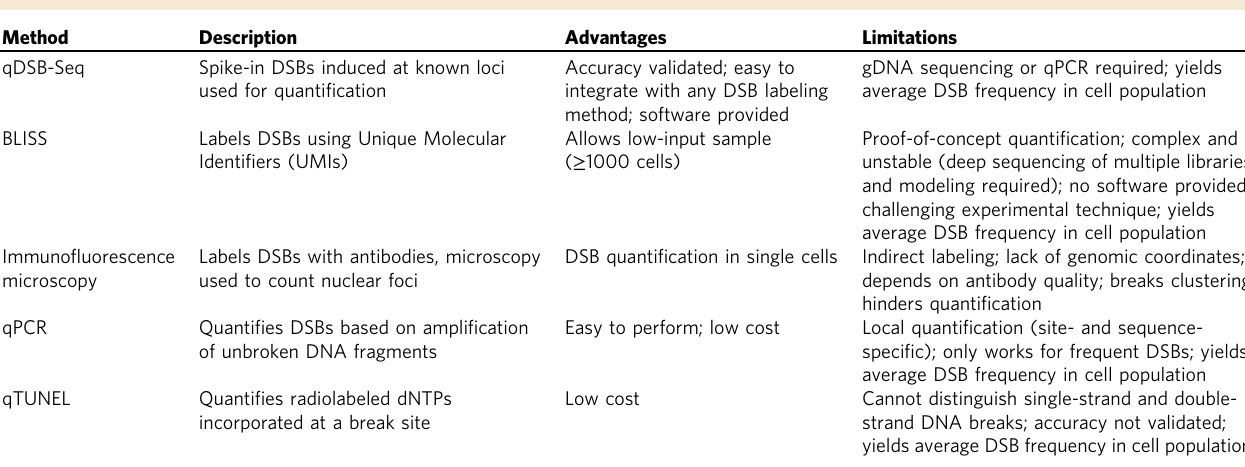
Fig. 5 DNA double-strand breaks at replication fork barriers. a Scheme of replication fork barriers (RFBs) at yeast ribosomal DNA locus. b The total number of RFB-related one-ended DSBs (peaks as de fi ned in c calculated from the difference of Watson and Crick strand reads (Methods)). DSBs per cell values and SD are shown ( n = 39, Methods). Source data are provided as a Source Data fi le. c Quanti fi ed DSB signal in RFB region. RFB1 and RFB2 are indicated by the red boxes on the top. The blue boxes mark Fob1 protein binding sites mapped in vitro. The yellow star indicates Top1 cleavage site. The signal originating from rDSB-1 and rDSB-2 is presented in blue, the signal from rDSB-3 we discovered is presented in red Table 1 Comparison of DSB quanti fi cation